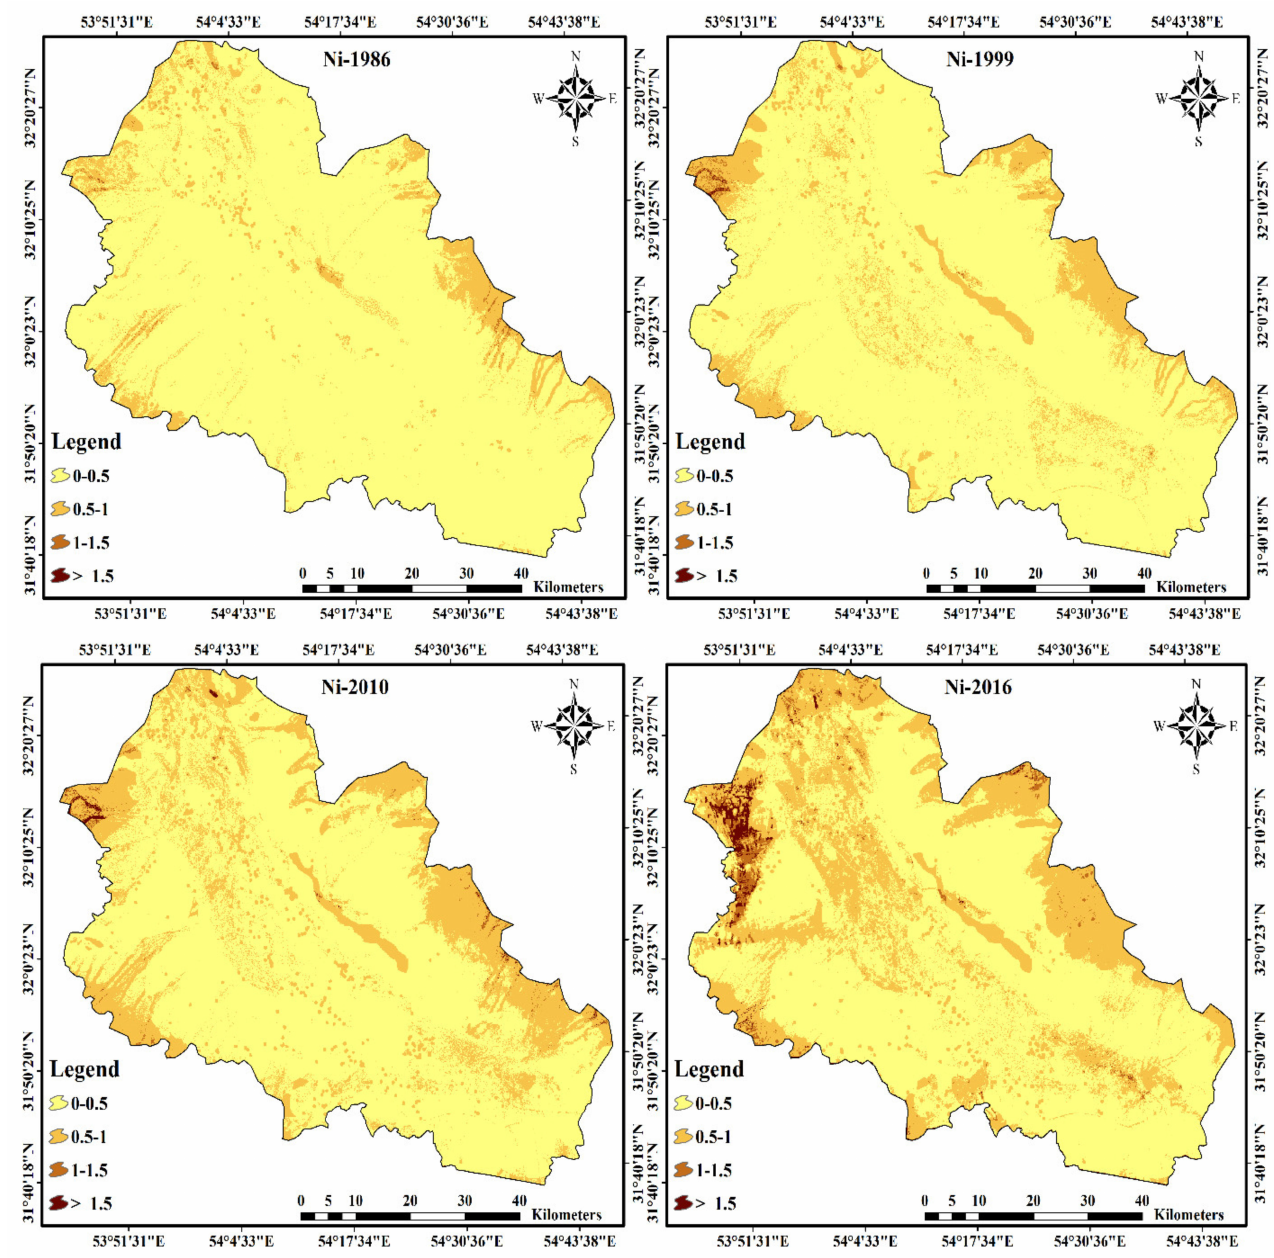
Figure 8. The spatial prediction of Ni (mg/kg − 1 ) for 1986, 1999, 2010, and 2016.